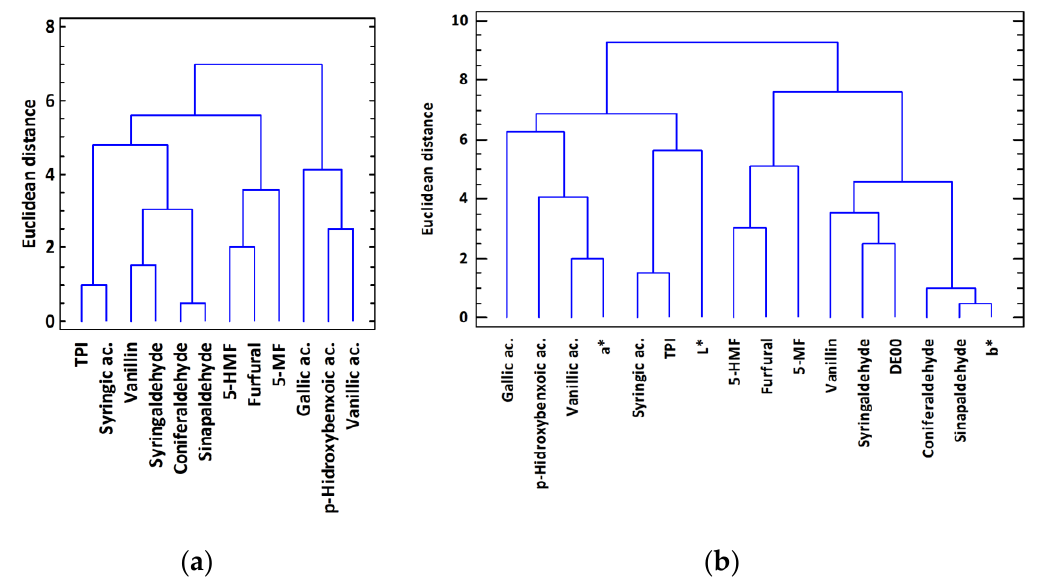
Figure 1. Cluster analysis obtained using the Euclidean distance as metrics and the Ward method as clustering rule for the standardized variables. ( a ) Phenolic content. ( b ) Phenolic content and chromatic characteristics.